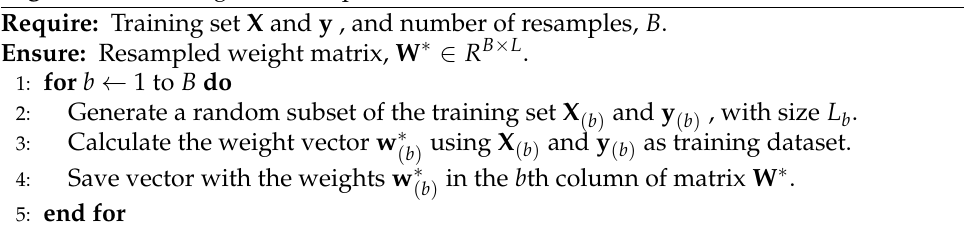
Algorithm 1 IVI-Algorithm Step 1.